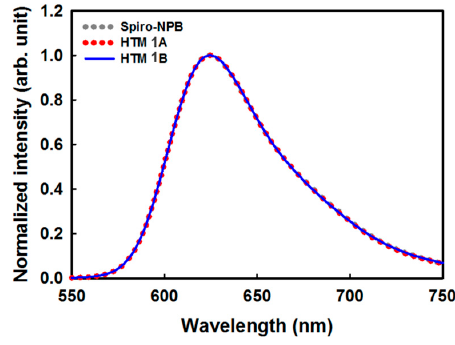
Figure 6. Normalized EL spectra of red phosphorescence based OLED devices.